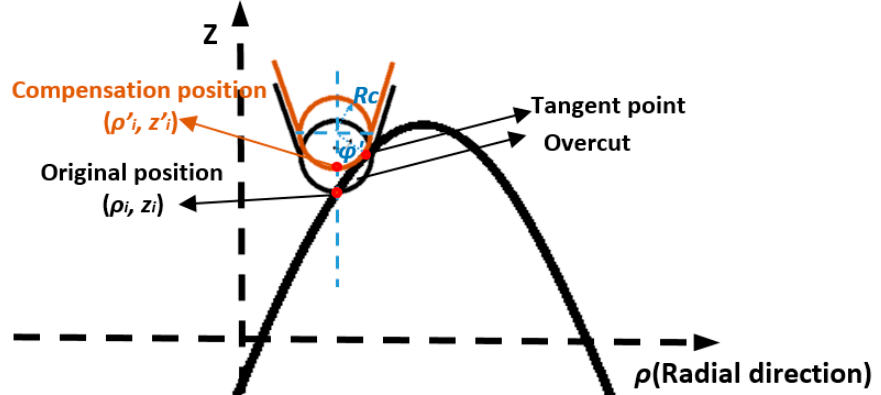
Figure 9. Tool radius compensation using the Z direction method.